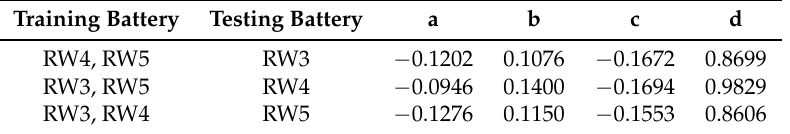
Table 5. Initial model parameters.